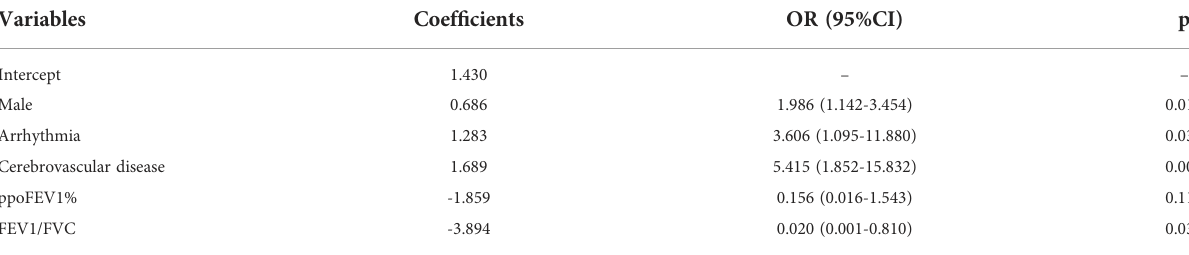
good discrimination and calibration. PpoFEV1% and FEV1/FVC were identi fi ed as the most important predictive factors. Three algorithms were used for model development: logistic regression, random forest, and XGBoost. They all have their strengths and weaknesses. The conventional logistic regression is strong in convenient implementation, clear presentation, and intuitive interpretation, but weak in capturing nonlinear relationships between outcomes and variables. As for novel machine learning algorithms like random forest and XGBoost,